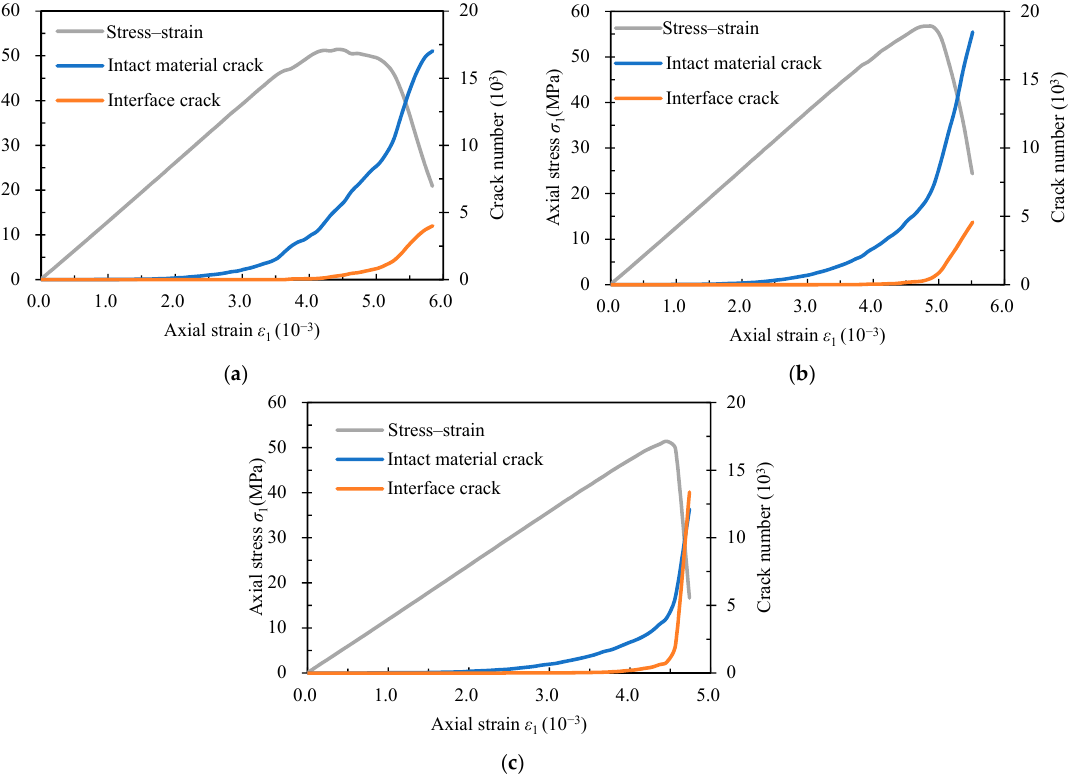
Figure 9. Crack number evolution of transversely isotropic rock models with dip angles of ( a ) α = 0°, ( b ) α = 15°, and ( c ) α = 30°.